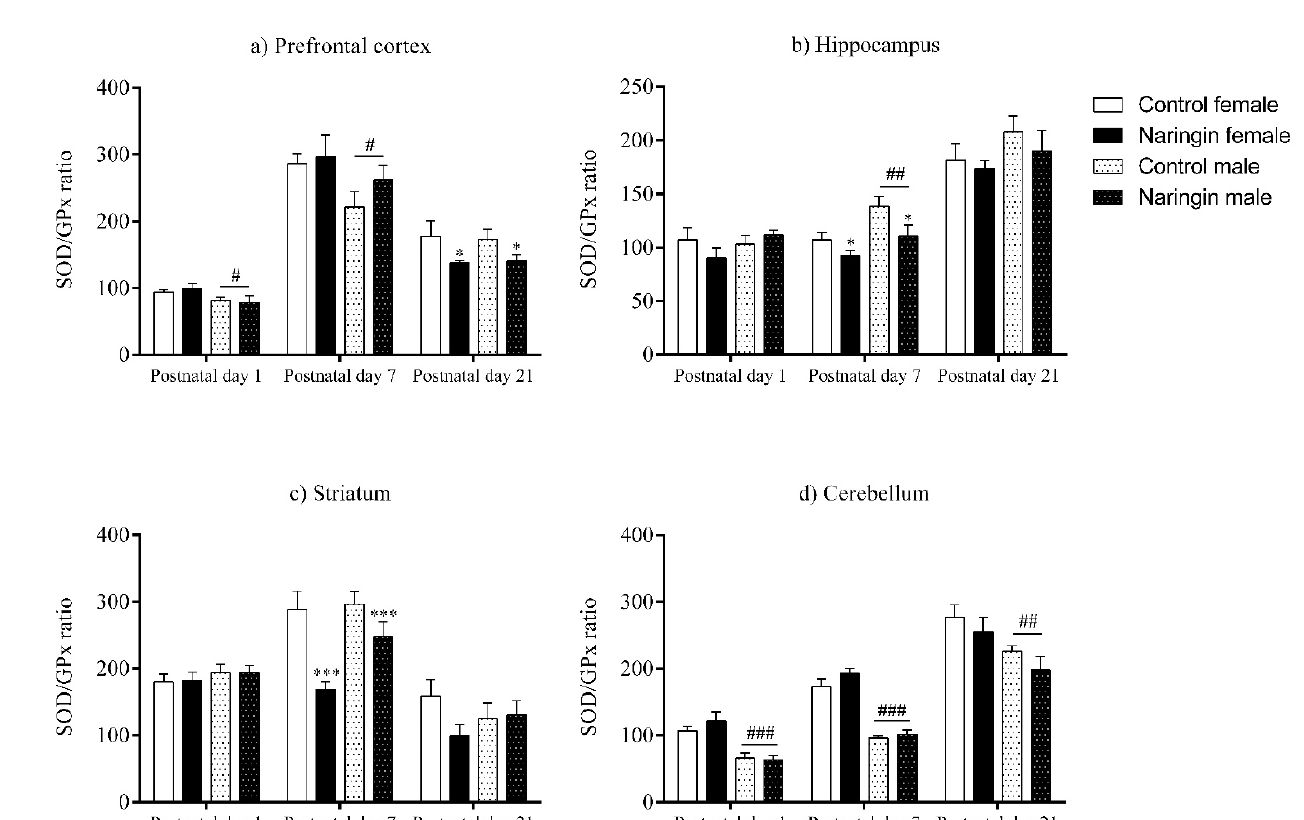
Figure 5. Effects of maternal naringin supplementation during the third week of gestation on the SOD/GPx ratio in the offspring’s ( a ) prefrontal cortex, ( b ) hippocampus, ( c ) striatum, and ( d ) cerebellum on postnatal days 1, 7, and 21. Results are expressed as mean ± S.E.M. Control female n = 8, naringin female n = 8, control male n = 8, naringin male n = 6. * p < 0.05; *** p < 0.001 # p < 0.05; ## p < 0.01; ### p < 0.001 (two-way ANOVA). Asterisks represent a main supplementation effect, and the hashes on bars represent a main sex effect. The asterisks on bars (single bracket) represent the significant comparisons by Sidak’s post-hoc test when interactions occurred.